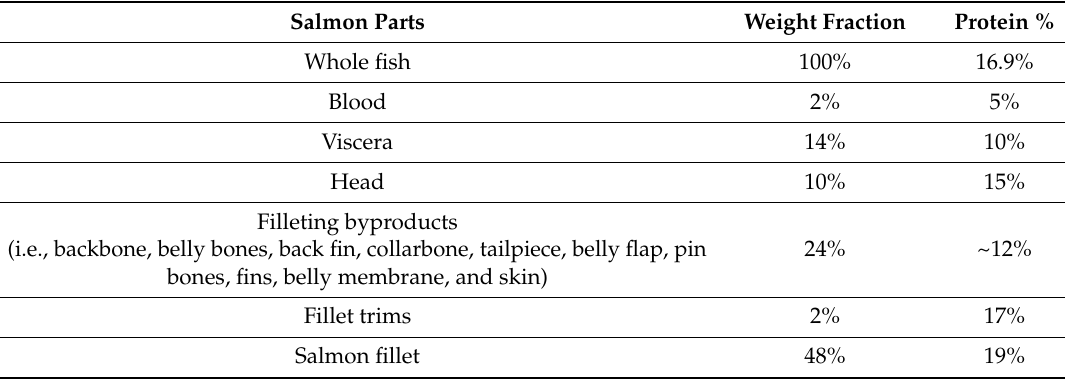
Table 1. Protein content in Atlantic salmon body parts *. Salmon Parts Weight